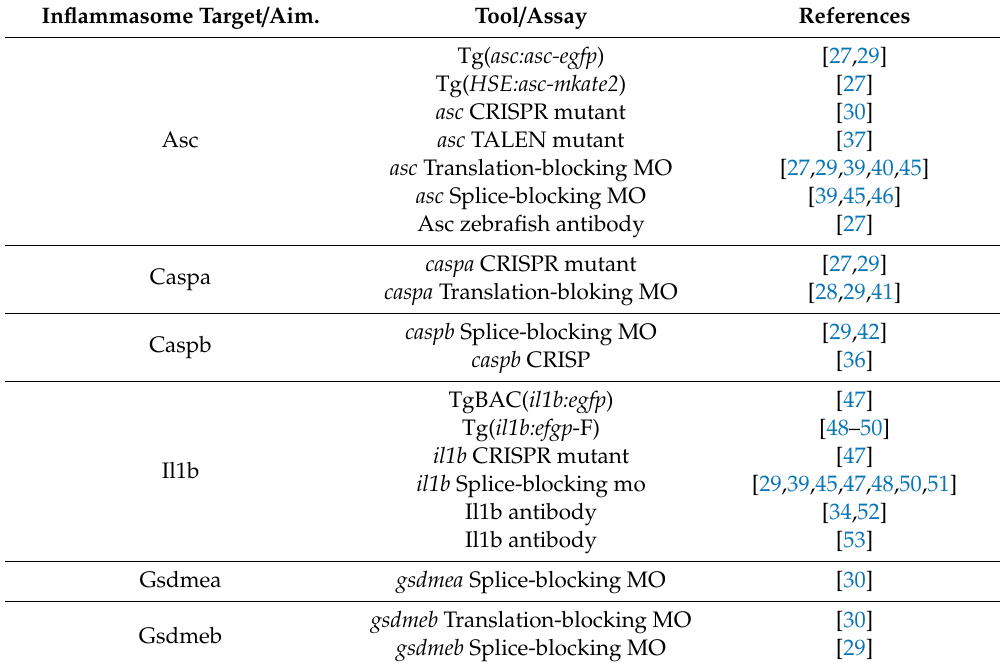
Table 2. Specific zebrafish tools available for inflammasome research. Inflammasome Target /